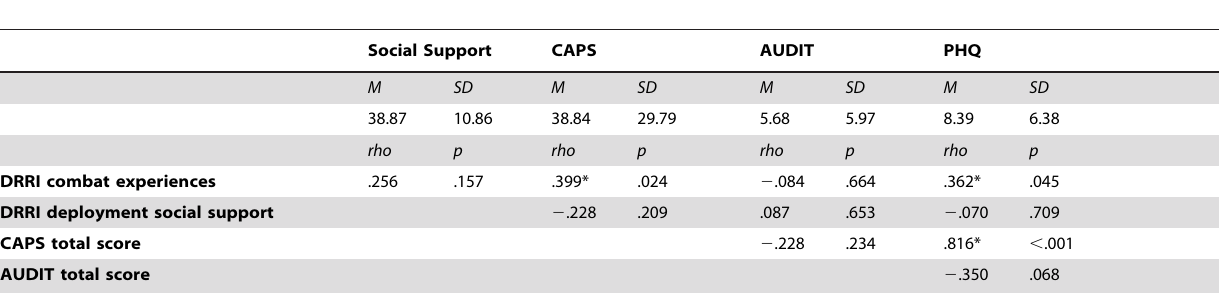
Table 1. Correlations between deployment experiences and post-deployment clinical